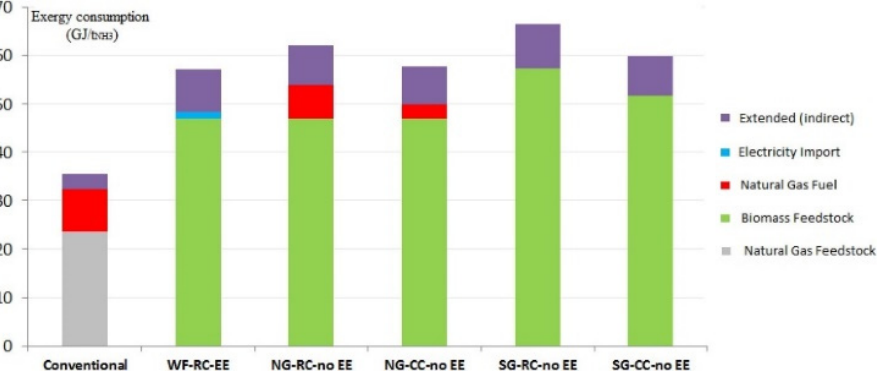
Figure 15. Comparing exergy consumption for the various methods of ammonia production, including conventional, WF-RC-EE, NG-RC-no EE, NG-CC-no EE, SG-RC-no EE, SG-CC-no EE. Reprinted with permission [69].